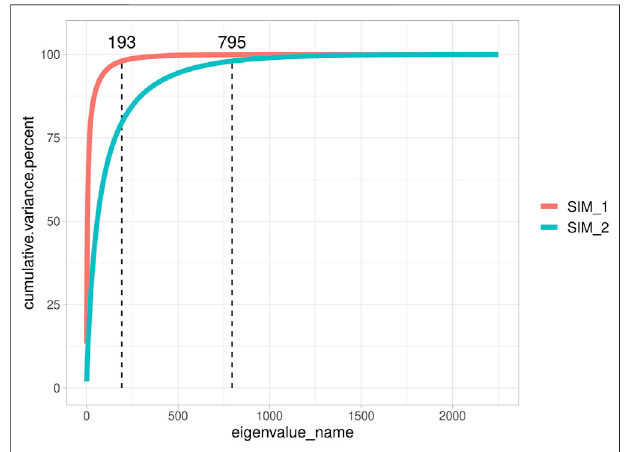
FIGURE 2 | Cumulative explained variance of all eigenvalues of the genomic relationship matrix of two representative simulated